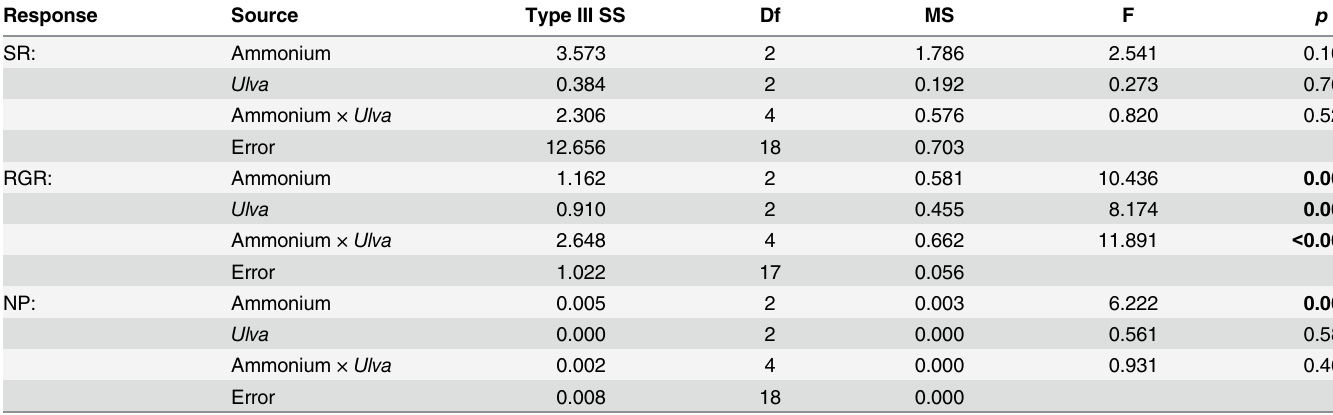
Table 1. ANOVA results testing the effects of ammonium and Ulva treatments on survival rate (SR), relative growth rate (RGR) and net production (NP) of Zostera noltei . Bold letters indicate significant differences.